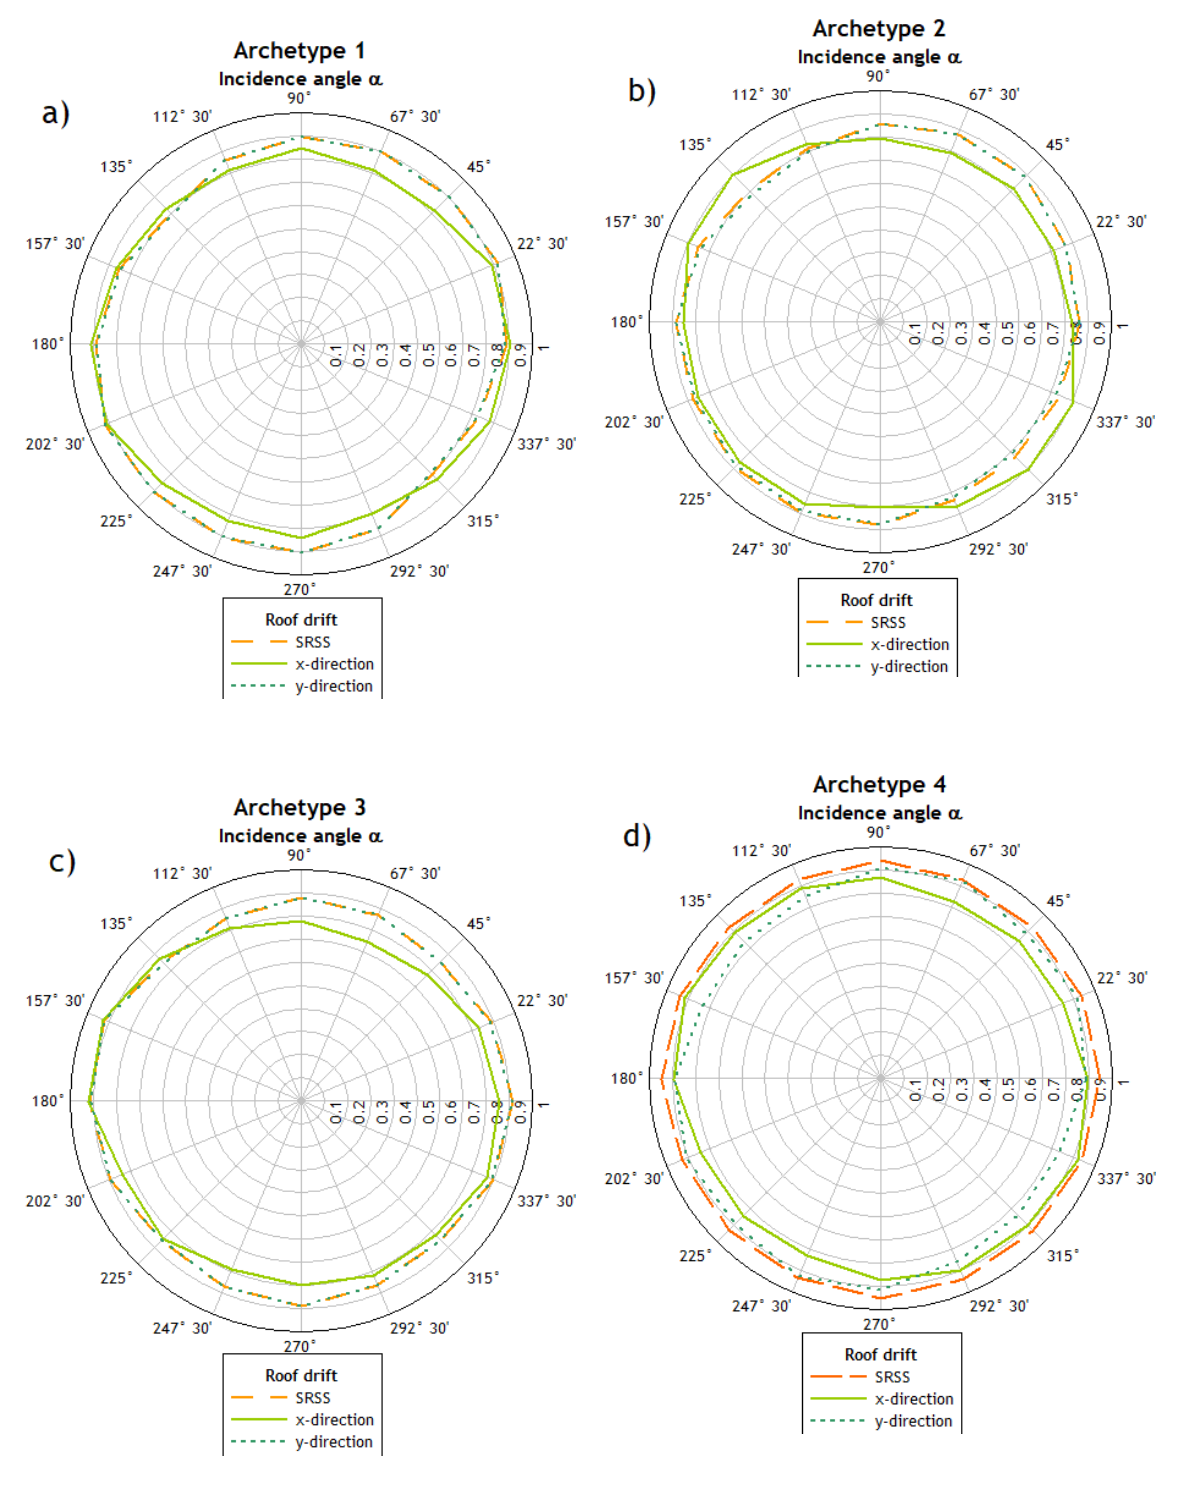
Figure 15. Mean roof displacement, SRSS combination for ( a ) Archetype 1, ( b ) Archetype 2, ( c ) ( c ) Archetype 3 and ( d ) Archetype